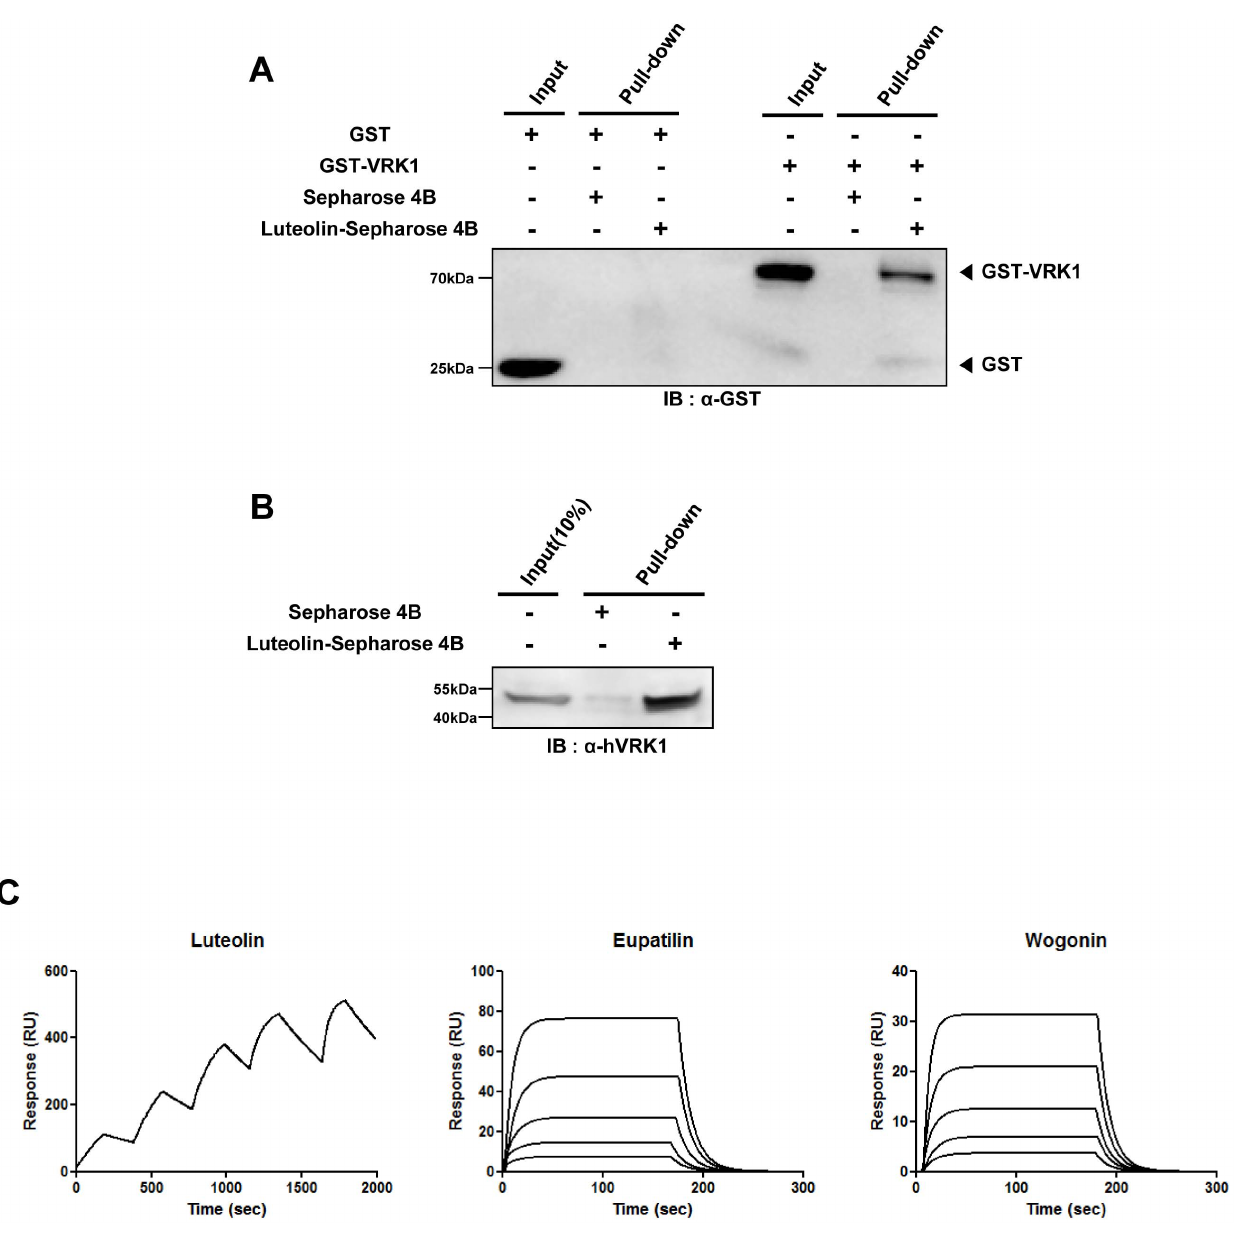
Figure 2. Direct interaction of luteolin with VRK1. (A), Pull-down assay using luteolin-conjugated sepharose 4B beads or control sepharose 4B beads with recombinant VRK1 protein. Purified GST and GST-VRK1 proteins are incubated with indicated beads, and then pull down assay was performed. Each proteins were detected by immunoblotting with GST antibody. (B), Pull-down assay using luteolin conjugated sepharose 4B beads with SH-SY5Y cell lysate. Cell lysate are incubated with indicated beads, and then pull-down was performed. The proteins were detected by immunoblotting with VRK1 antibody. (C), SPR detection for the interaction of luteolin with VRK1. The data were obtained by kinetic titration method with sequentially injection of analytes without regeneration steps. Data for eupatilin and wogonin were obtained by classical